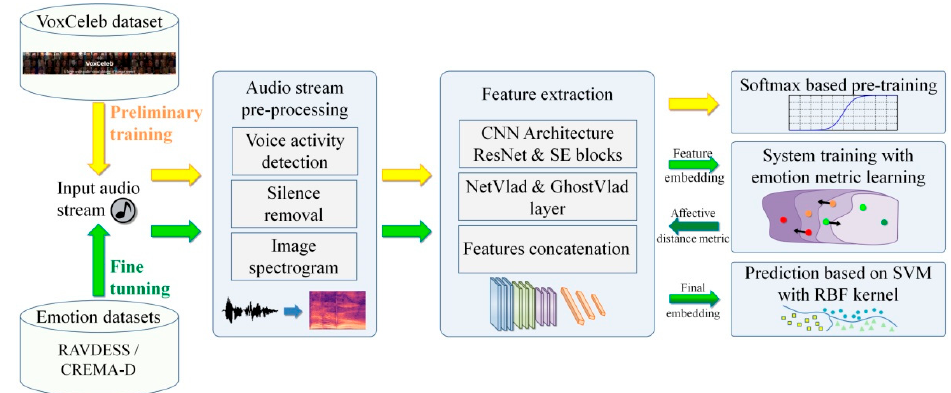
Figure 1. The proposed methodological framework with the main steps involved: audio ‐ stream preprocessing, feature extraction and utterance level aggregation, system training with emotion metric learning and SVM training.